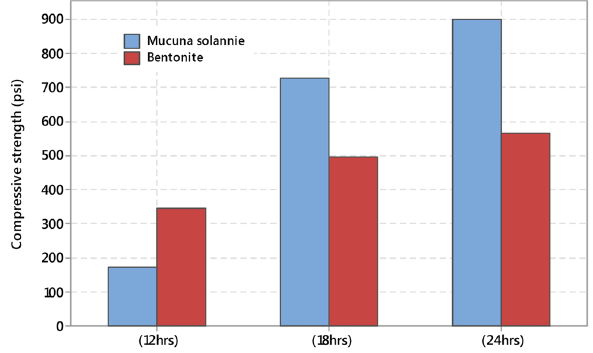
Fig. 13 Compressive strength of cement sheet formulated with Mucuna solannie and Bentonite extenders at 200 °F (93.3 °C)